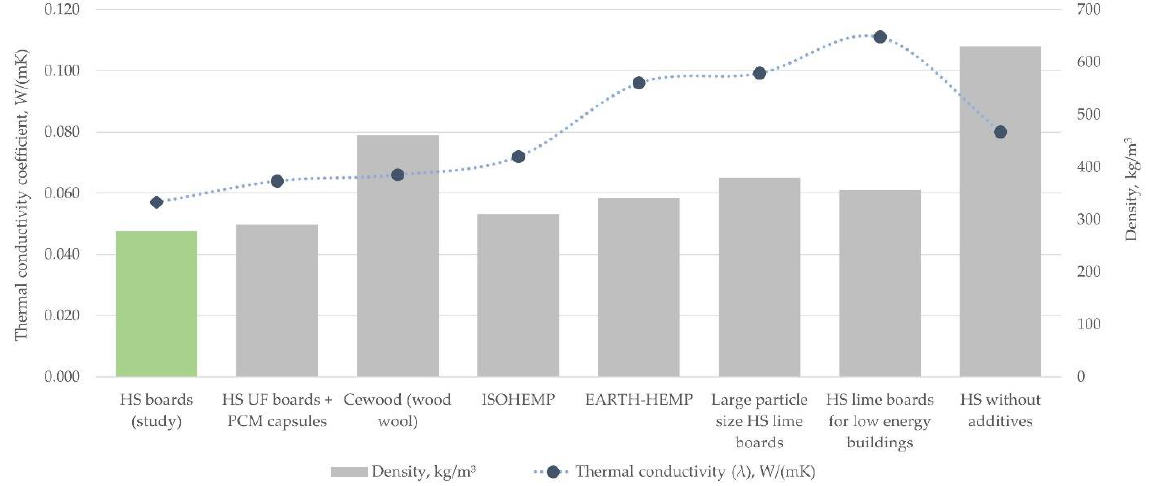
Figure 11. Thermal conductivity of hemp shive board samples in comparison to similar materials consisting of hemp or wood particles [47–50,53,64,65].